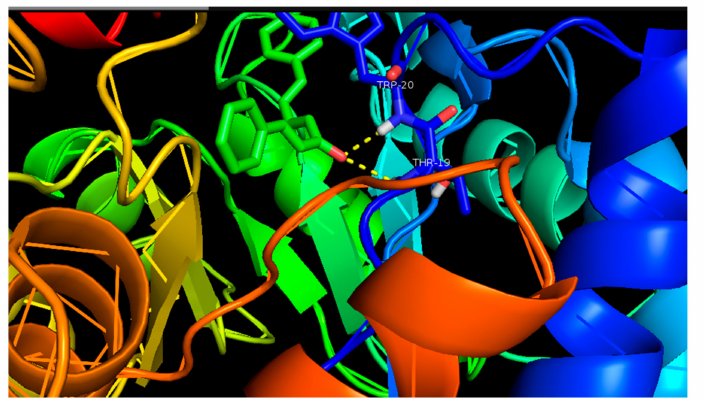
Figure 4. Ligand–receptor interaction mode of curcuminoid 10g with the AR enzyme. The interaction of 10g between oxygen (red) and hydrogen (grey) of amino